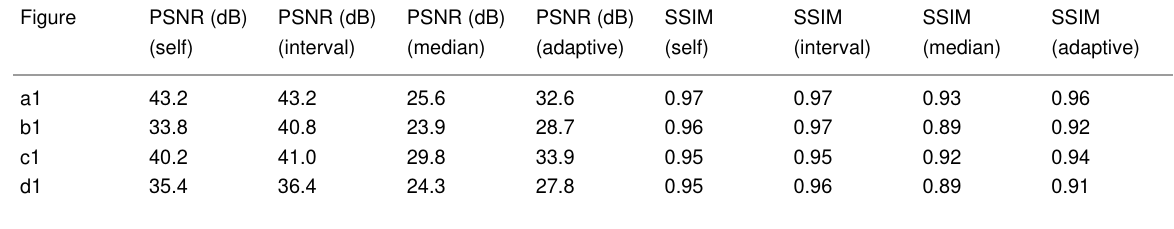
Table 1: Denoising results of the images in Figure 5. “Self” refers to the self-comparison-BCS denoising, “interval” refers to the interval-BCS denoising, “median” refers to the median filter, and “adaptive” refers to the adaptive median